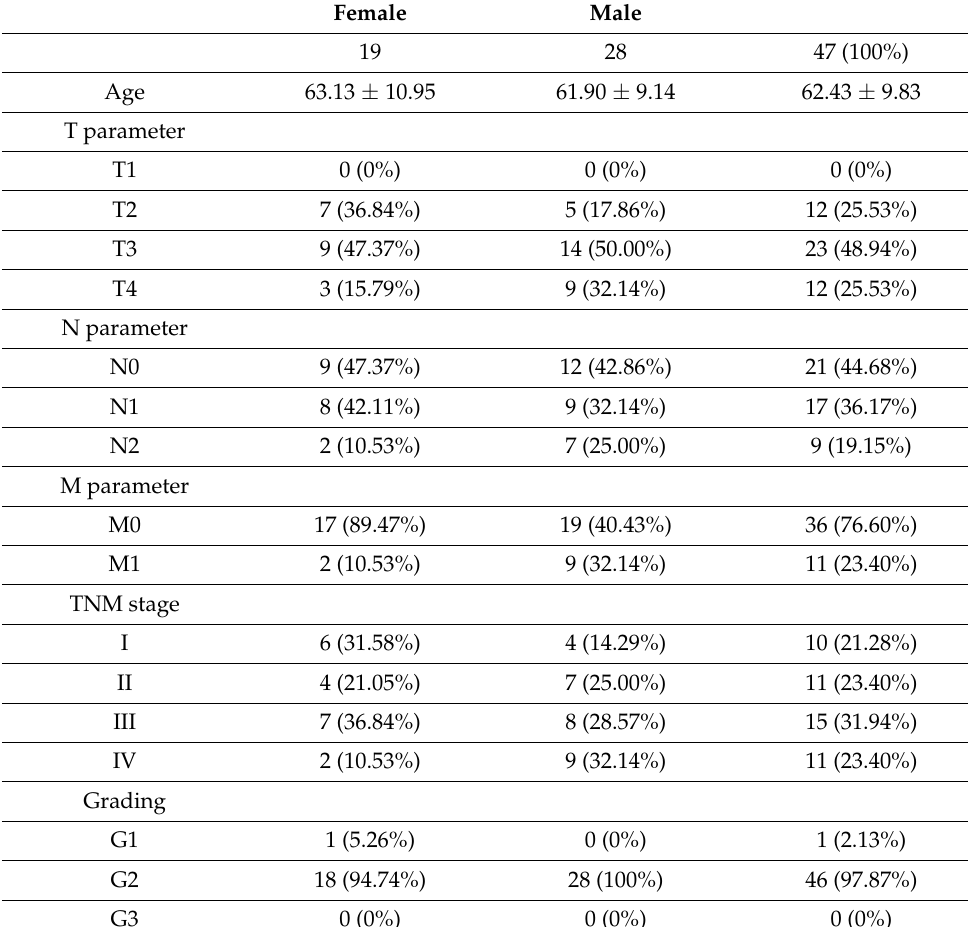
Table 1. Characteristics of the